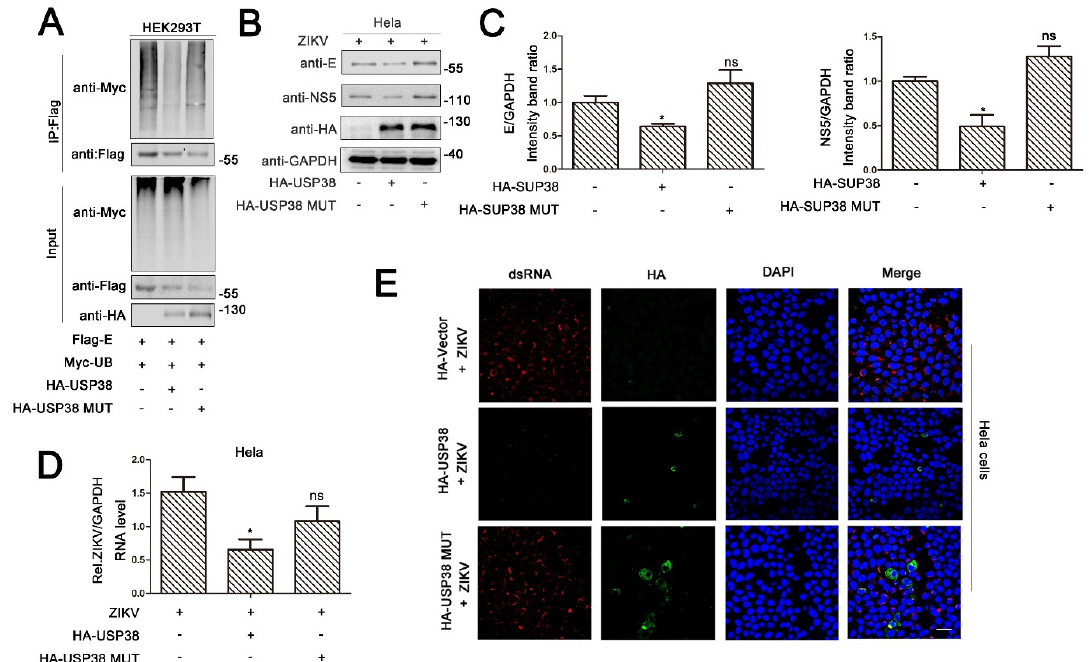
Figure 4. Deubiquitinase activity of USP38 is required for restriction of ZIKV infection. ( A ) HEK293T cells were co-transfected with Flag-E and Myc-UB, together with HA-USP38 or HA-USP38 (C454A/H857A/D918N). Cell lysates were immunoprecipitated with anti-Flag and immunoblotted with anti-Myc. ( B – E ) Hela cells were transfected with HA-USP38, HA-Vector or HA-USP38 (C454A/H857A/D918N) for 24 h then infected with ZIKV (MOI = 1) for 48 h. The expression level of ZIKV proteins were detected by immunoblotting ( B ). The ratios of E/GAPDH and NS5/GAPDH ratio were measured ( C ). The viral RNA content was quantified by qPCR ( D ) and confocal microscopy ( E ), bar = 10 µ m .